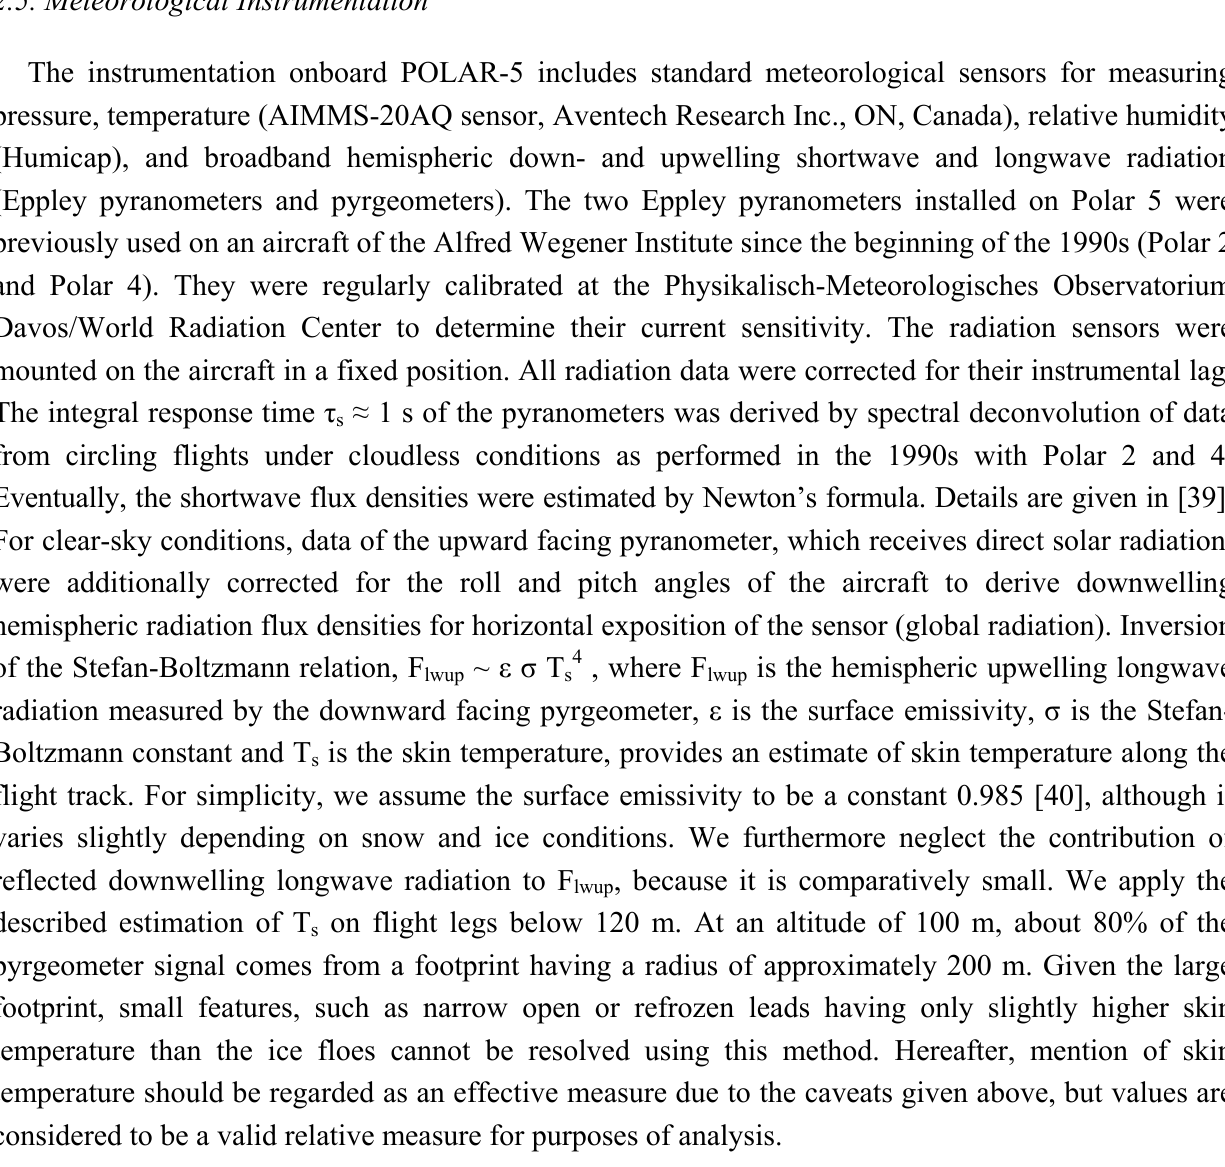
Figure 1. ( a ) Sea level pressure and ( b ) Two meter temperature data (European Centre for Medium-Range Weather Forecasts (ECMWF) analyses) averaged over the time period